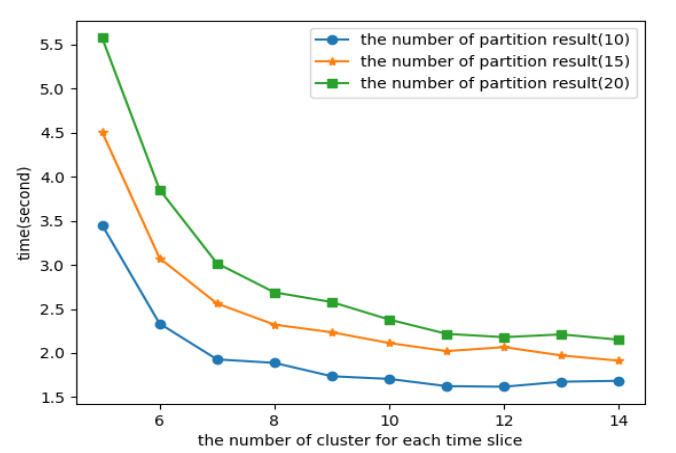
Figure 6. Time cost (Geolife dataset).